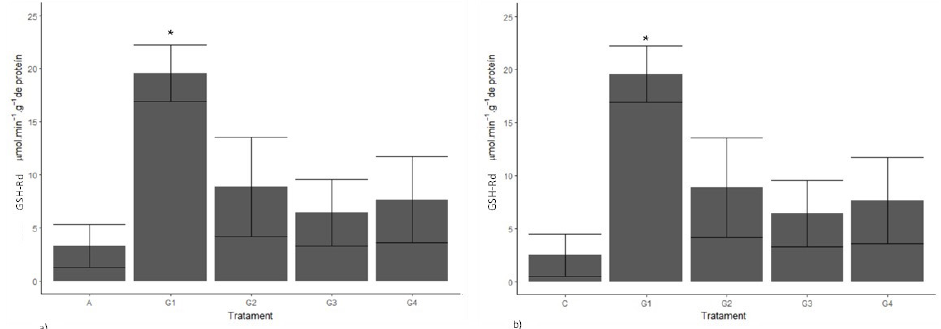
Figure 1. Comparison of GSH-Rd enzyme activities in the myocardium of rats exposed to DOX. a) Comparison between the sham (A) and PSEE-treated groups: G1 (Group 1), G2 (Group 2), G3 (Group 3) and G4 (Group 4), in which G1 presented a significantly higher GSH-Rd activity (* = p <0.05) than the sham group (A). b) Comparison between the control (C) and PSEE-treated groups, in which G1 presented a significantly higher GSH-Rd activity (* = p <0.05) than the control group (C); The bars and lines indicate the means and standard error,